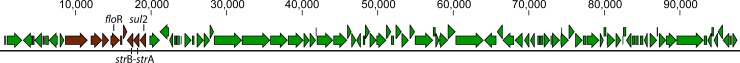
A graphical representation of the ICE fragment ICEVchInd5.The arrows represent the genes. The numbers indicate bp. position on the ICE fragment, with position 1 starting at the first bp of the fragment. The brown arrows represent the genes that were missing from the less-resistant sub-clone.